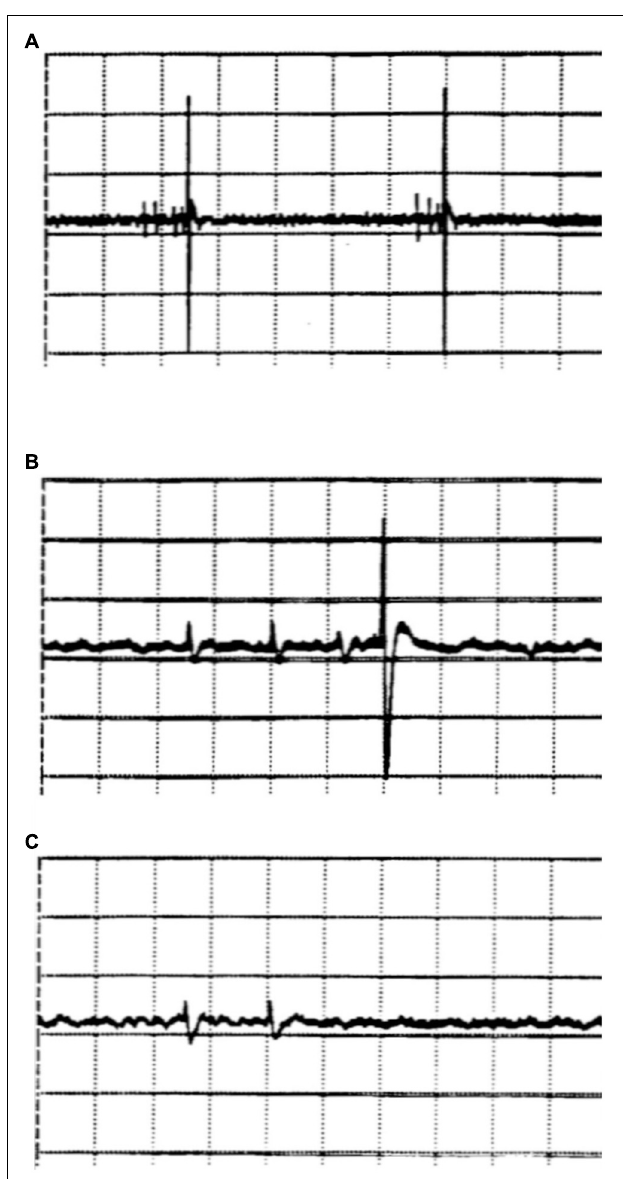
FIGURE 4 | Extracellular registrations of action potentials from hypothalamic brain slices of the rat (nucleus paraventricularis). The figures, screenshots from the oscillograph, show the action potentials (APs) of two different neurons, which can be distinguished by their very different amplitudes (ordinate: 50 µ V/Div). Groups of small action potentials are followed by a single large action potential ( A , time base: 200 ms/Div). The lower traces, plotted in higher time resolution (50 ms/Div), show a burst triplet of small spikes followed by a big spike (B) , whereas a big spike does not occur after a burst doublet (C)